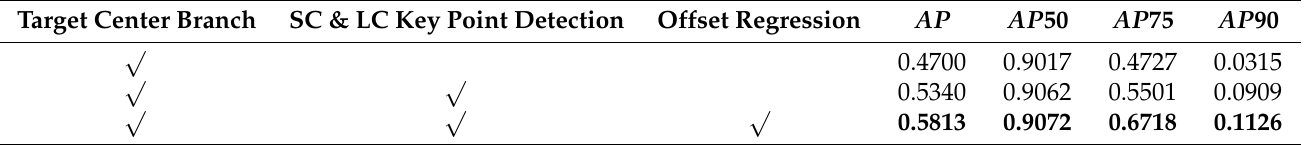
Table 5. Ablation Study on